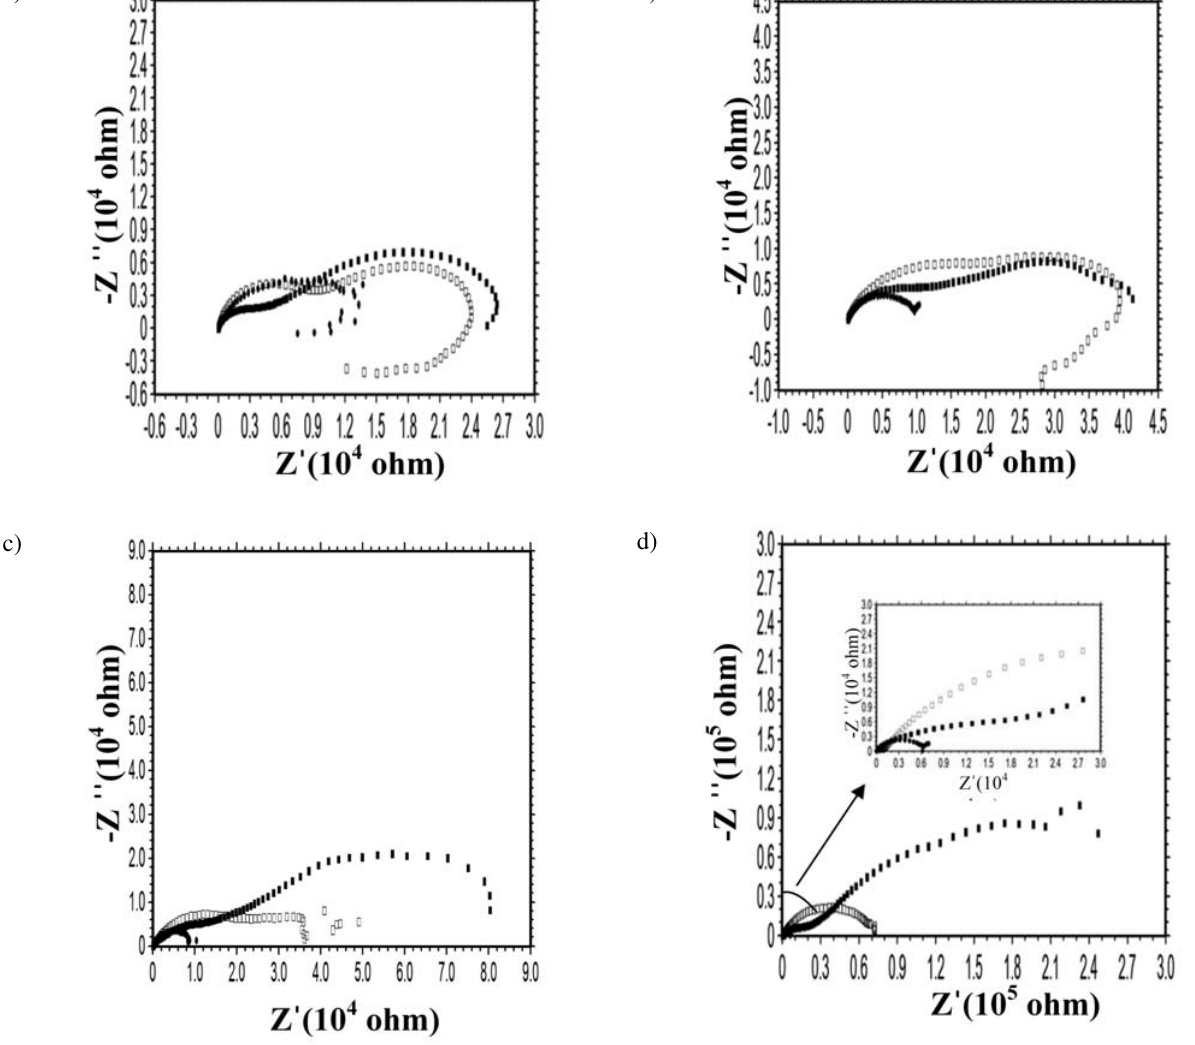
Fig. 3. The Nyquist plots recorded for CS ( (cid:2) ), CS/ZnNi ( (cid:3) ) and CS/ZnNi/PNMP ( (cid:4) ) electrodes after 2 (a), 48 (b), 96 (c) and 168 h (d) of exposu- re time in 3.5% NaCl